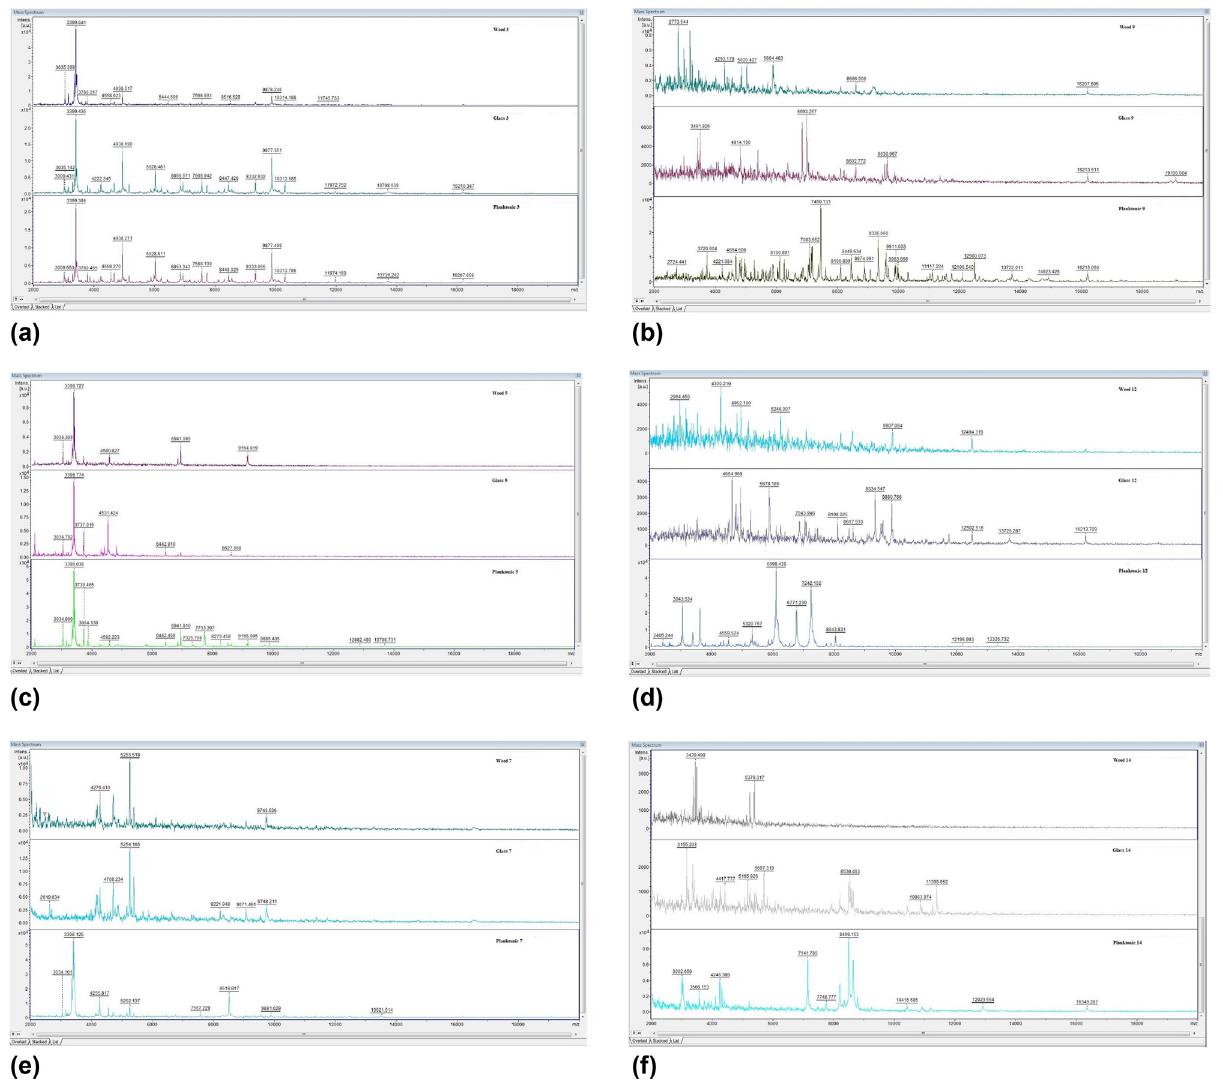
Figure 6: MALDI - TOF mass spectra of S. maltophilia after the CCEO treatment, days: ( a ) 3th, ( b ) 5th, ( c ) 7th, ( d ) 9th, ( e ) 12th, ( f )